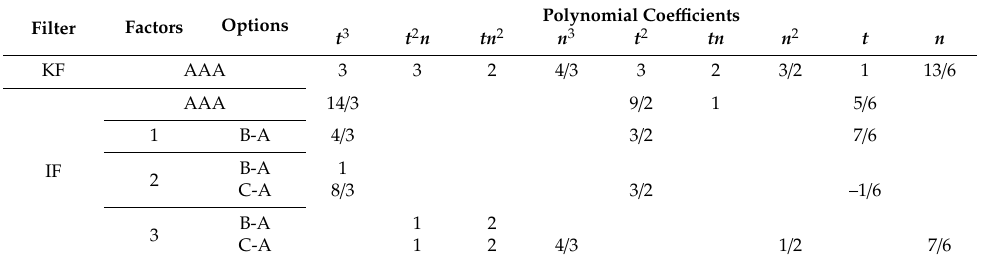
Table 4. Polynomial coe ffi cients of scalar addition operation. IF: information filter, KF: Kalman filter.